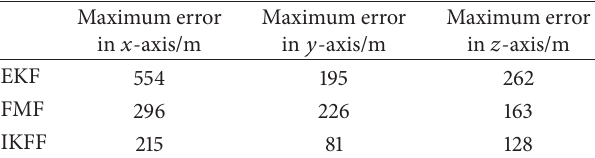
Table 3: The maximum AOD error of 𝐿 2 using different methods.